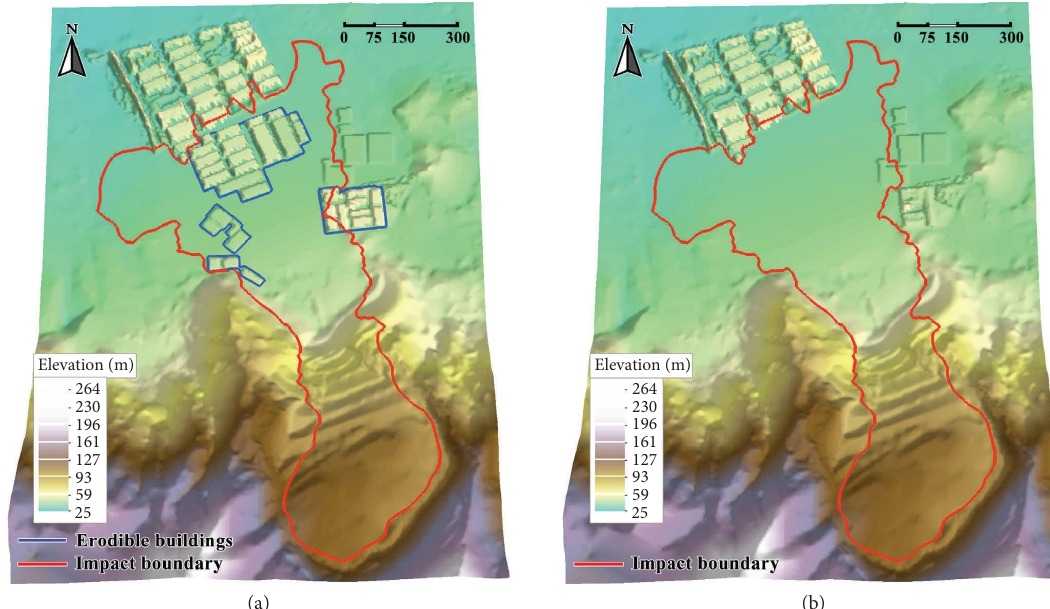
Figure 5: Digital elevation model of the Shenzhen 2015 landslide: (a) before the landslide (buildings that will be destroyed are marked with blue solid lines ), (b) after the landslide (destroyed buildings are